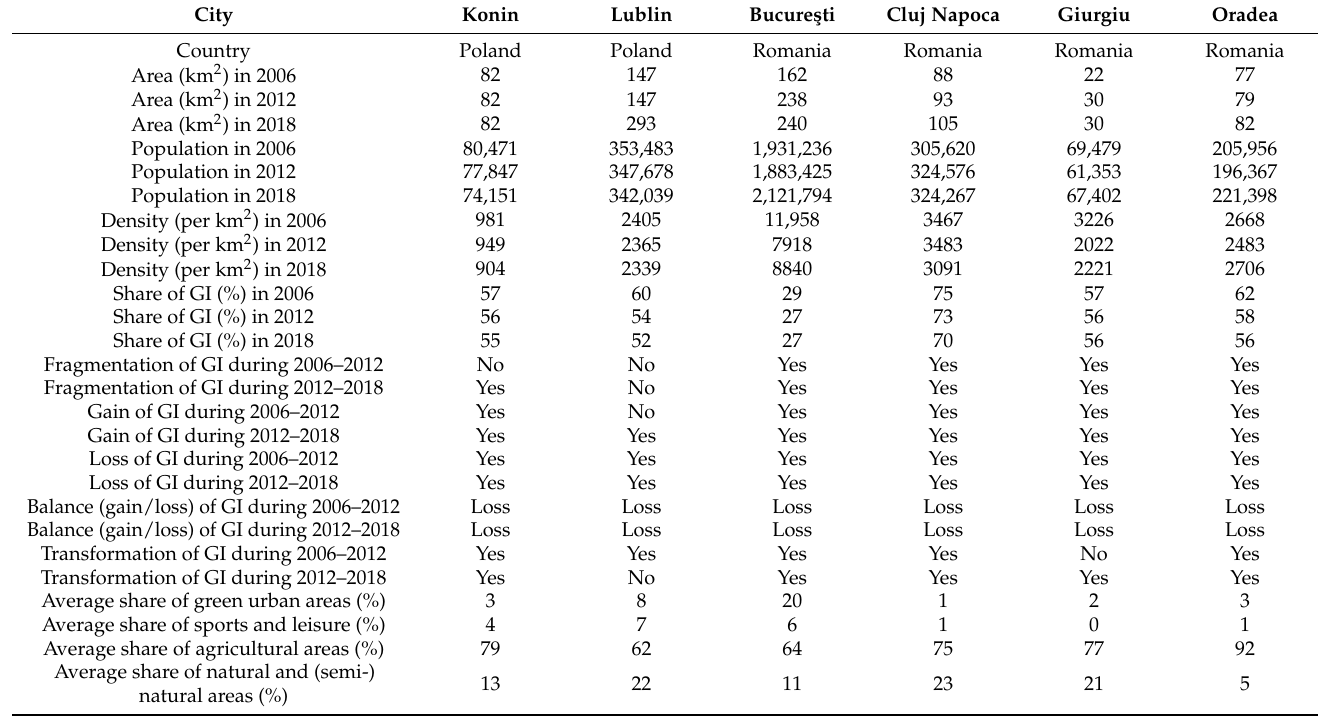
Table 5. Data for the individual case studies included in the qualitative analyses. The table displays physical and demographical characteristics and the dynamics of